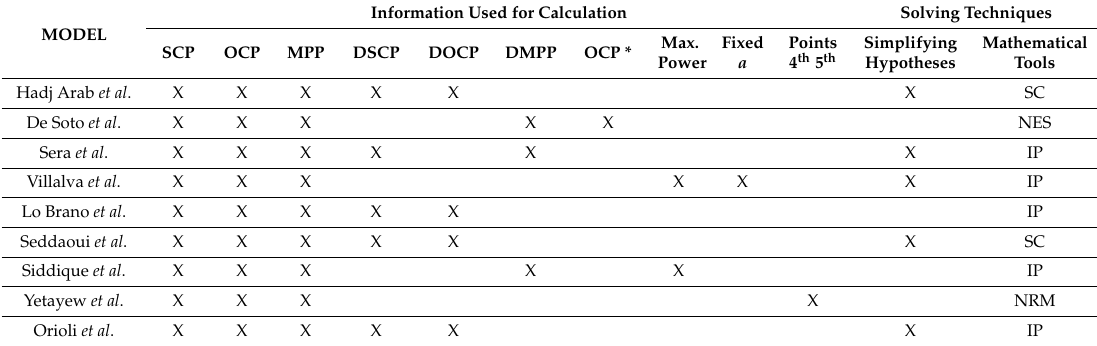
Information Used for Calculation